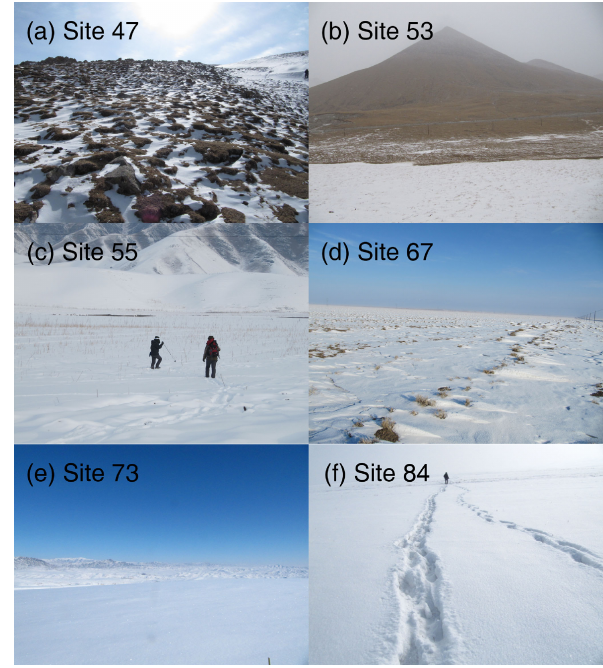
Figure 2. Pictures of typical sample